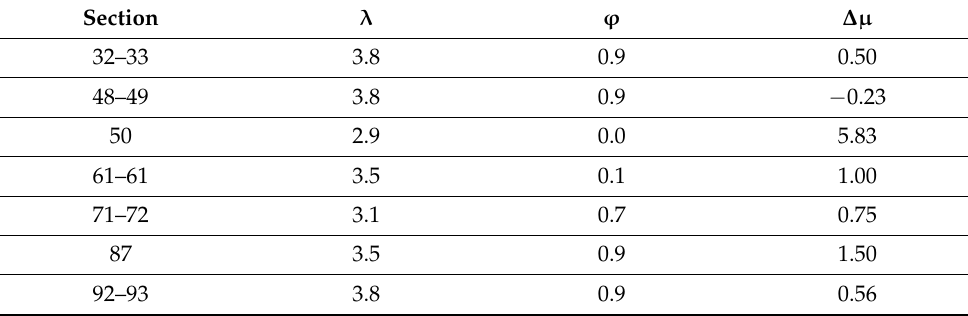
Table 5. Slenderness, filling ratio, and displacement ratio at failure.